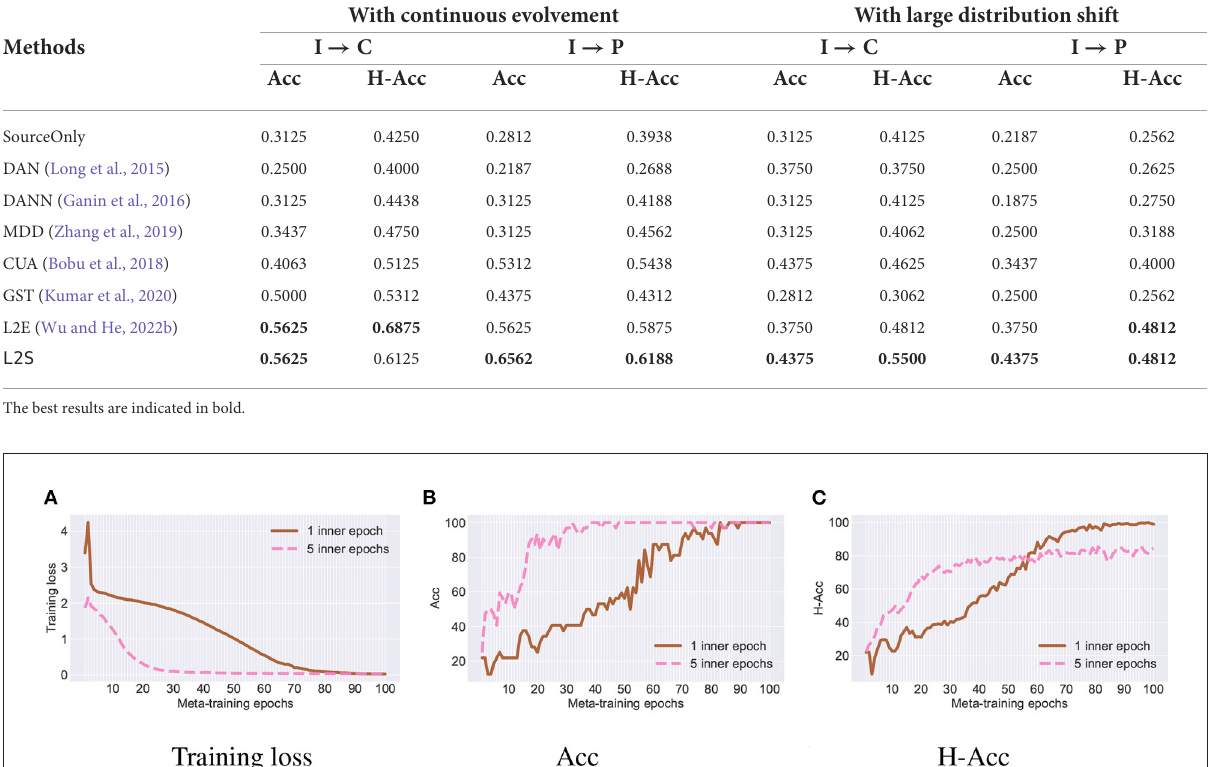
TABLE 2 Results of dynamic transfer learning on ImageCLEF-DA.